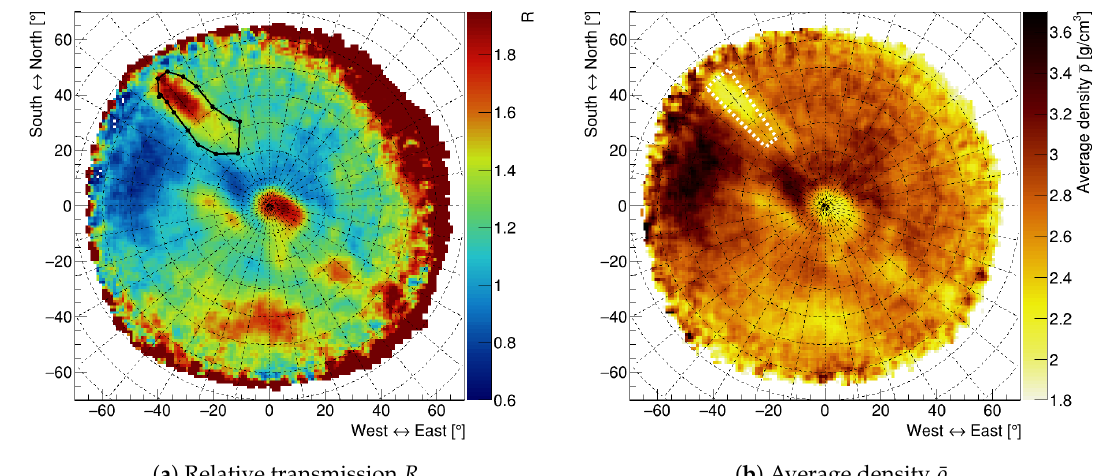
Figure 6. Relative transmission and average density maps in the polar reference frame with smoothing filter. The first part of the Gran Cava is marked with black points. Similarity to the dark area of Figure 3a can be observed thanks to the choice of the polar reference frame. The angular region indicated by the white dotted line in the density map was used to validate the presence of the